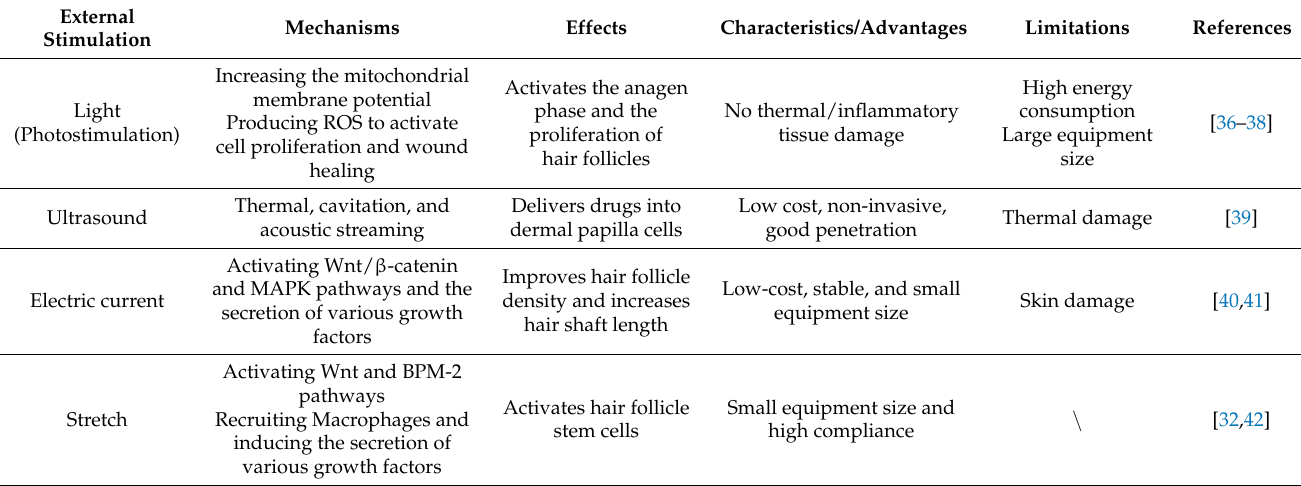
Table 2. Summary of external stimulation for hair